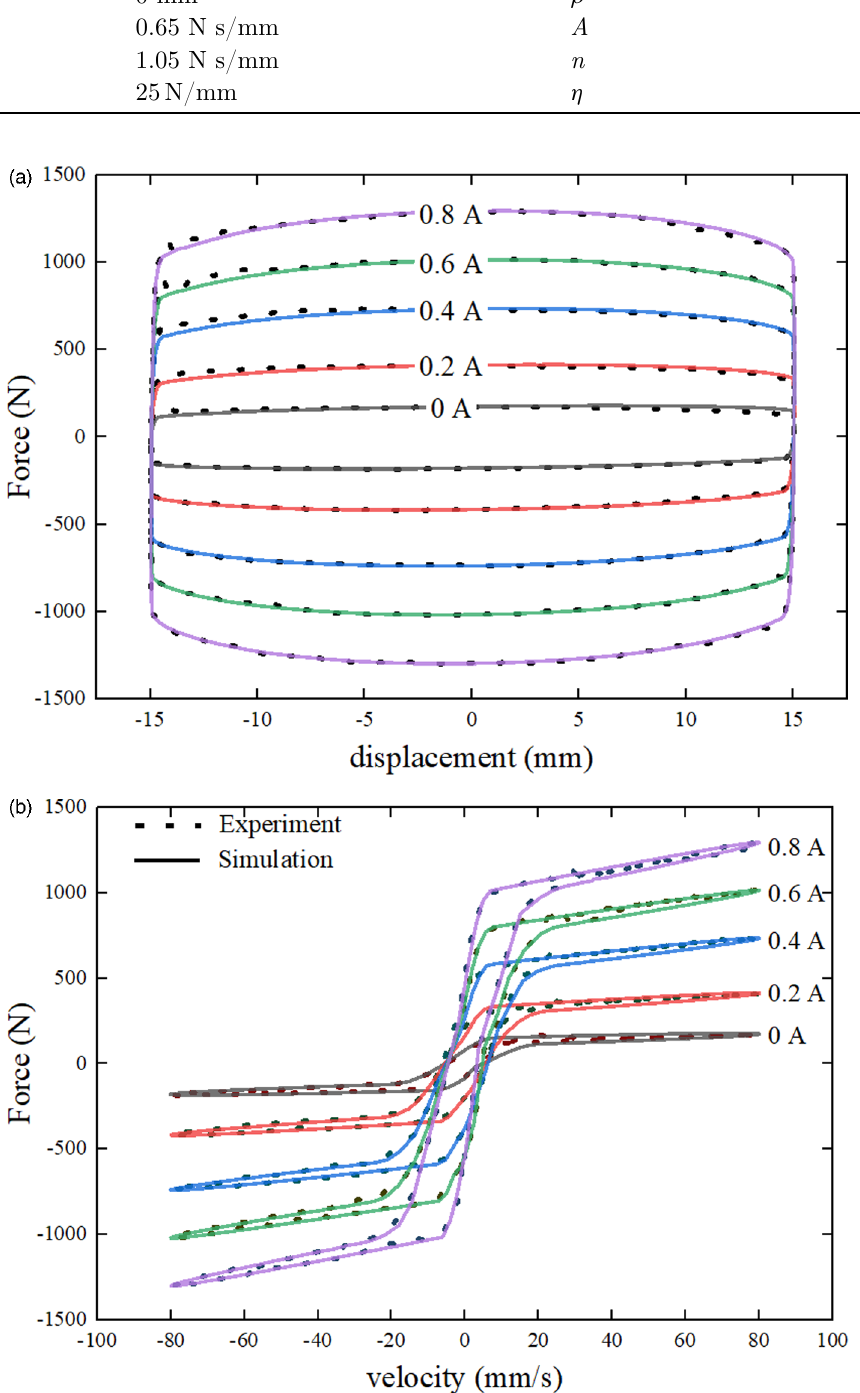
Fig. 5. Comparison between the experimental data and the simulation results of the phenomenon model identi fi ed by IFA: (a) Force vs. displacement; (b) Force vs.